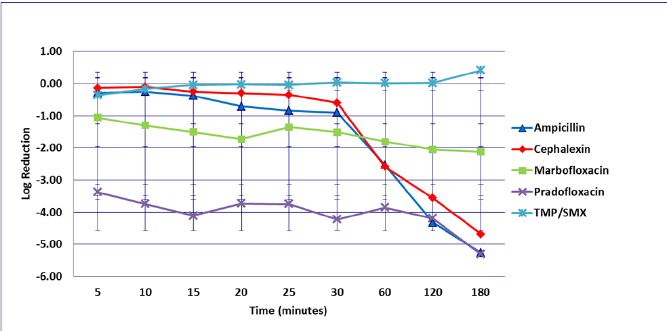
Figure 11. Log 10 reduction in P. mirabilis with bacterial cells exposed to ampicillin, cephalexin, marbofloxacin, pradofloxacin, and trimethoprim/sulfamethoxazole at the maximum serum drug concentration. Pradofloxacin vs. marbofloxacin at 15 min, p = 0.0133. Pradofloxacin vs. TMP/SMX at 60, 120, and 180 min, p values 0.0058, 0.0009, <0.0001. Marbofloxacin vs. TMP/SMX at 15, 20, 25, 30, 60, 120, and 180 min, p values from <0.0001 to 0.0170. Cephalexin vs. marbofloxacin at 25 min, p = 0.0091. Cephalexin vs. TMP/SMX at 120 and 180 min, p = 0.0032 and <0.0001. TMP/SMX vs. ampicillin at 180 min, p <0.0001. Data points present mean ± standard deviation.